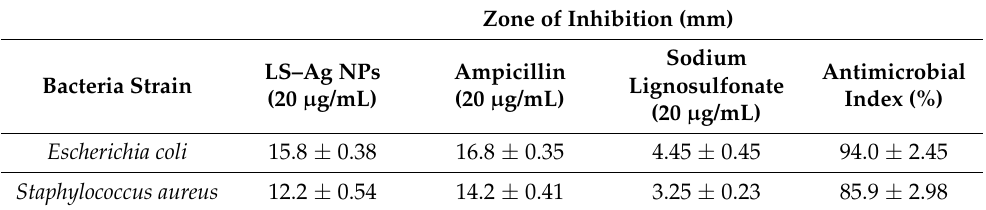
Figure 10. ( a ) Antioxidant potential in terms of scavenging activity against highly stable DPPH; and ( b ) antidiabetic potential (inhibition) against α -glucosidase by synthesized LS–Ag NPs. Table 2. Antimicrobial activity of Ta-Ag NPs against pathogenic microorganisms E. coli and S. aureus